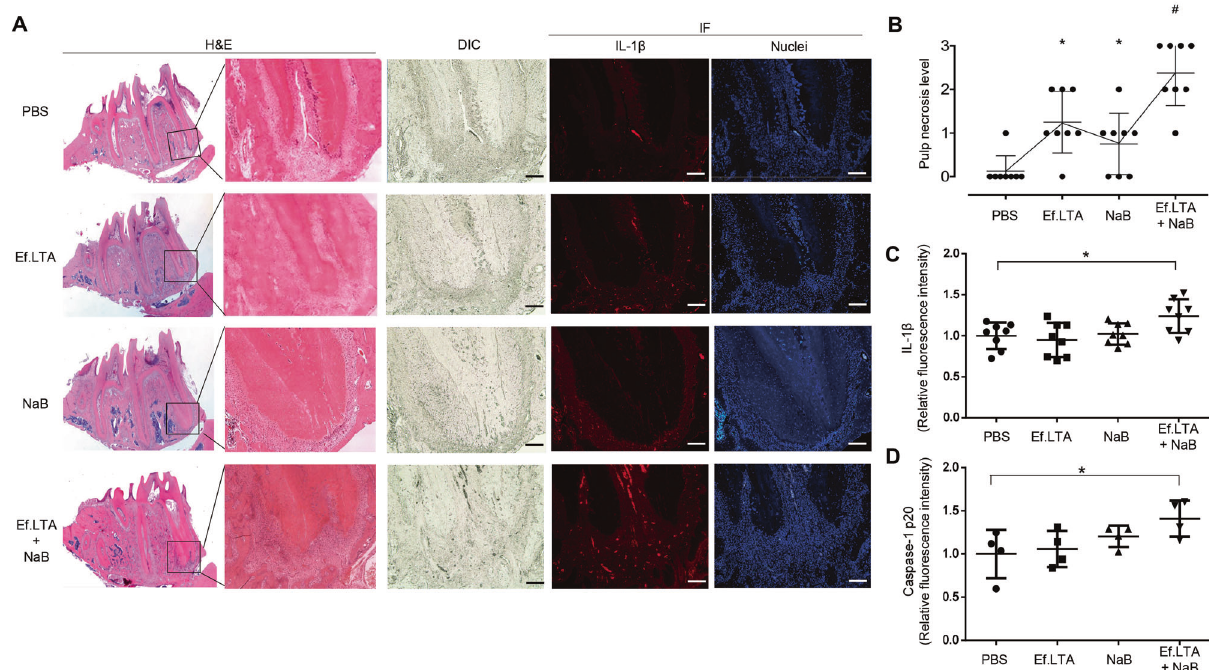
Fig. 8 Ef.LTA together with NaB cooperatively increases IL-1 β expression around the root apex in rat apical periodontitis model. Six- week-old female pathogen-free Sprague-Dawley rats were anesthetized and the pulp of bilateral fi rst mandibular molars was exposed. A collagen sheet soaked with PBS, 10 μ g of Ef.LTA, 10 mM of NaB, or Ef.LTA/NaB was inserted into the pulp chamber and then plugged with a sterile cotton pellet. A After 4 weeks, the mandibles were fi xed and decalci fi ed. Decalci fi ed mandibles were embedded in paraf fi n, sectioned longitudinally and attached to glass slides. The sections of the mandibular molars were stained with H&E, and the expression of IL-1 β was identi fi ed by immuno fl uorescence staining using anti-rat IL-1 β antibody. Nuclei were stained with Hoechst 33258. The samples were observed using fl uorescence microscopy. DIC = differential interference contrast. Scale bars = 200 μ m. B The pulp necrosis level was assessed histometrically for the root canal of each tooth. Score 0 indicates no pulp cell necrosis in the entire root. Scores of 1, 2, and 3 indicate partial necrosis in the coronal one-third of the root canal, necrosis in two-thirds of the whole root canal, and full necrosis of the root canal, respectively. C , D Quantitative analysis of the relative fl uorescence intensity was performed using ZEN software. * p < 0.05. Cell Death Discovery (2023)